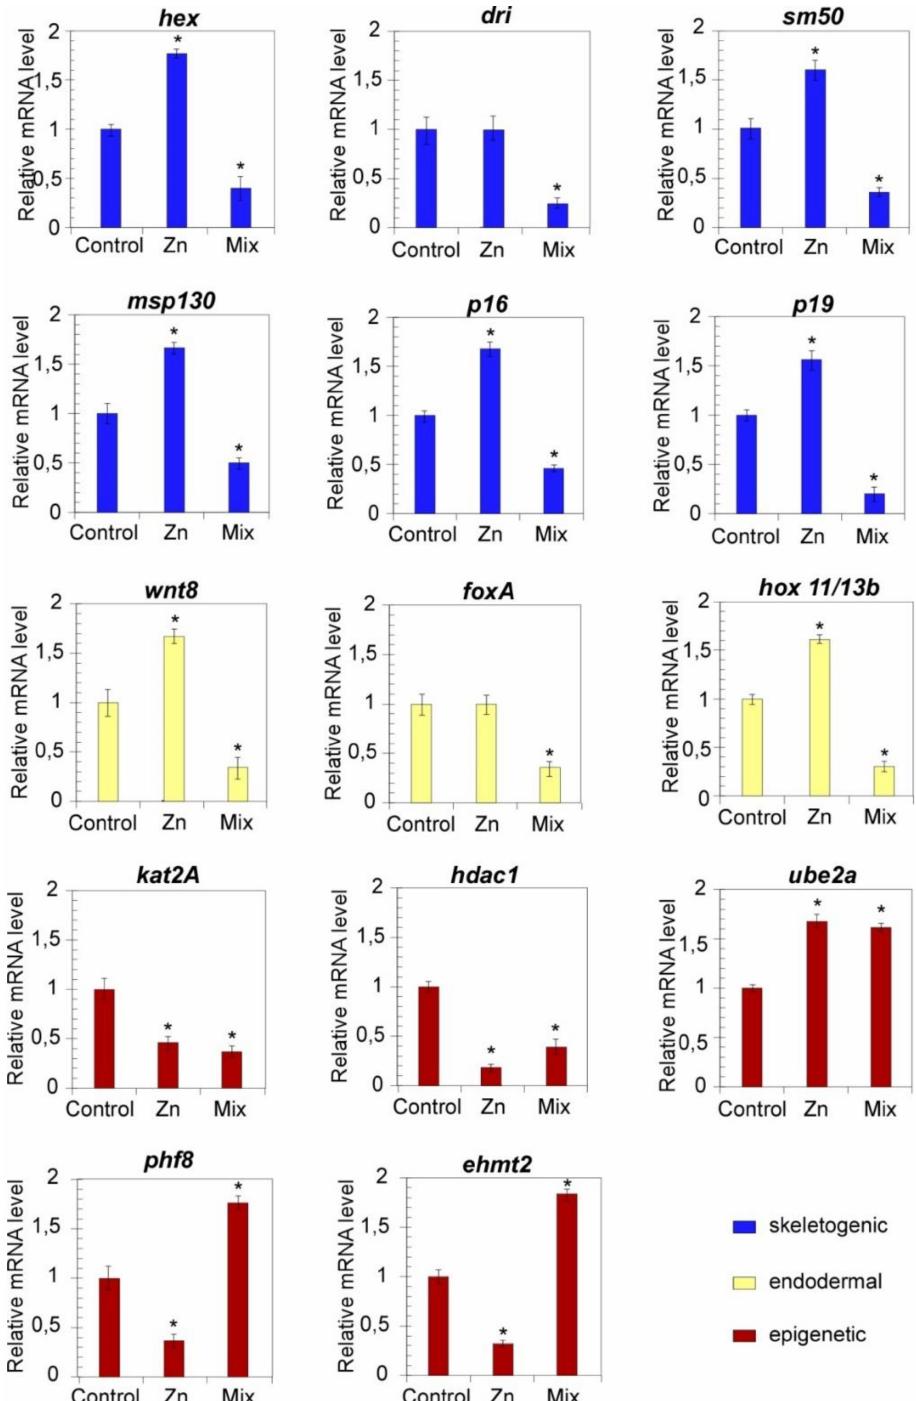
Figure 4. Parental exposures to low doses of Zn and metal mixture (as defined in Table 1) induce alterations in the mRNA expression of development and epigenetic related genes at 48 hpf. RT-qPCR results showing the mRNA levels of indicated genes in P. lividus offspring, with respect to 18S at 48 hpf. Bars represent mean ± SD. Values were considered statistically significant at p less than 0.05